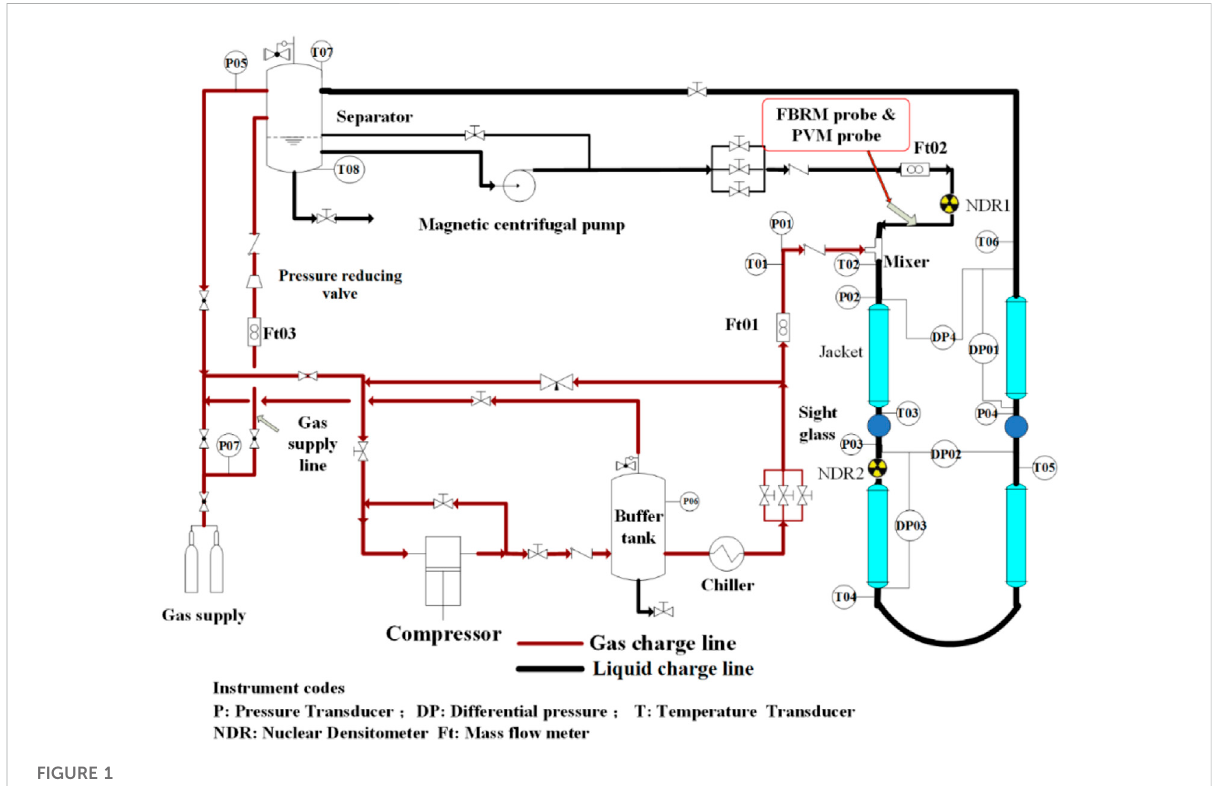
FIGURE 1 Schematic diagram of the high-pressure fl ow loop (Liu et al., 2018).